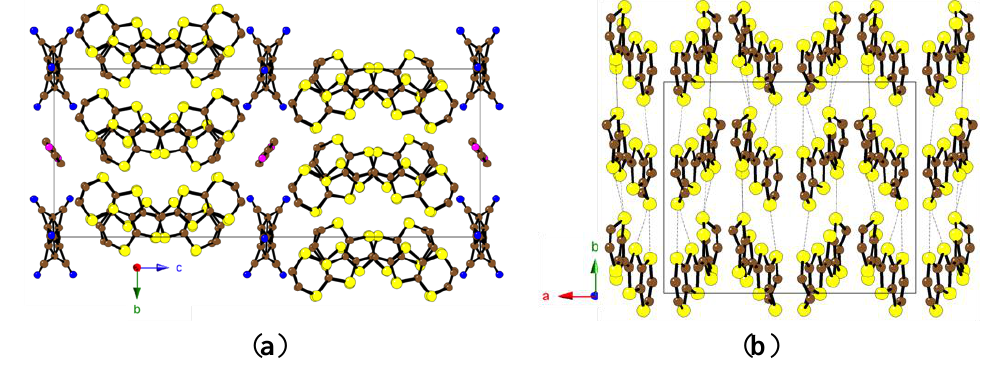
Figure 1. ( a ) View of the alternating cationic and anionic layers in compound 1 along the c axis (similar structure for compound 2 ); ( b ) View of the ET layer. Dotted lines indicate the S···S contacts shorter than the sum of the van der Waals radii; ( c ) Side view of the ET chains; ( d ) View of the overlap between neighboring ET molecules in the